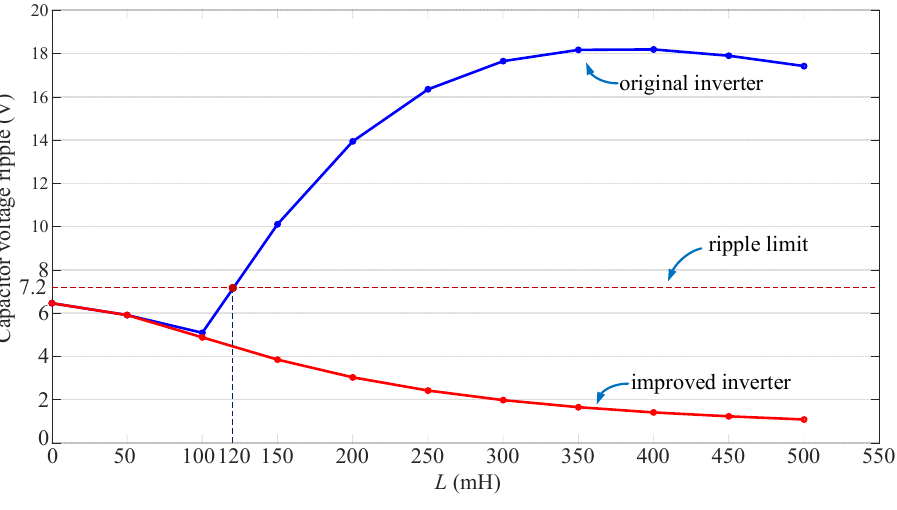
Figure 11. Capacitor voltage ripple versus load inductance ( R = 50 Ω